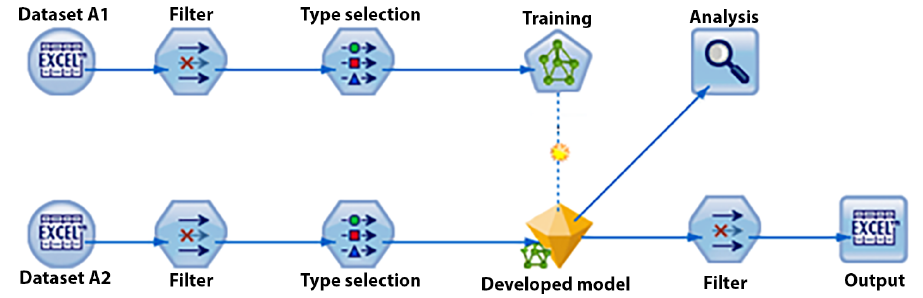
Figure 8. Scoring data stream developed in IBM SPSS.